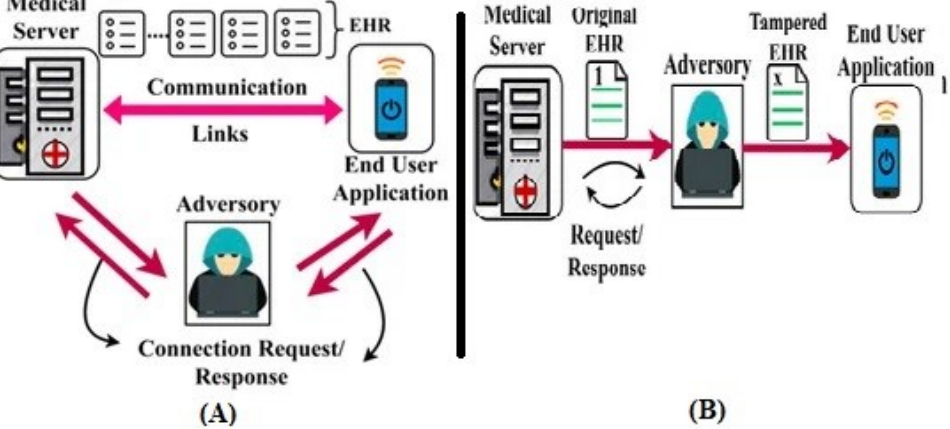
Figure 12. ( A ) Connection Setup in between end user App and Medical server. ( B ) Medical server response to end user App [80]. response to end user App